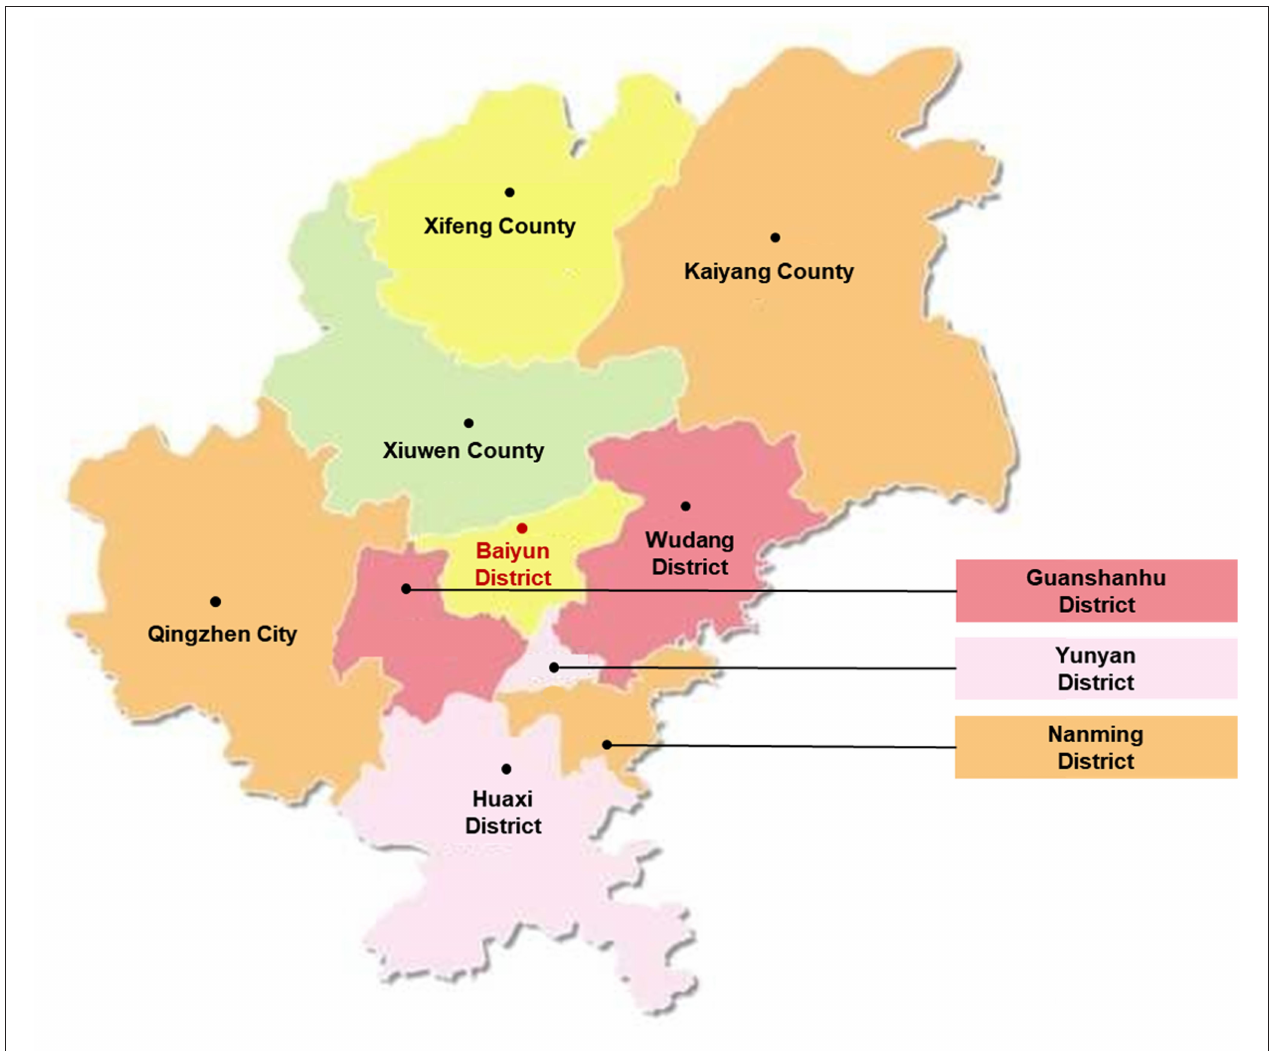
FIGURE 1 | Map of Baiyun District, Guiyang